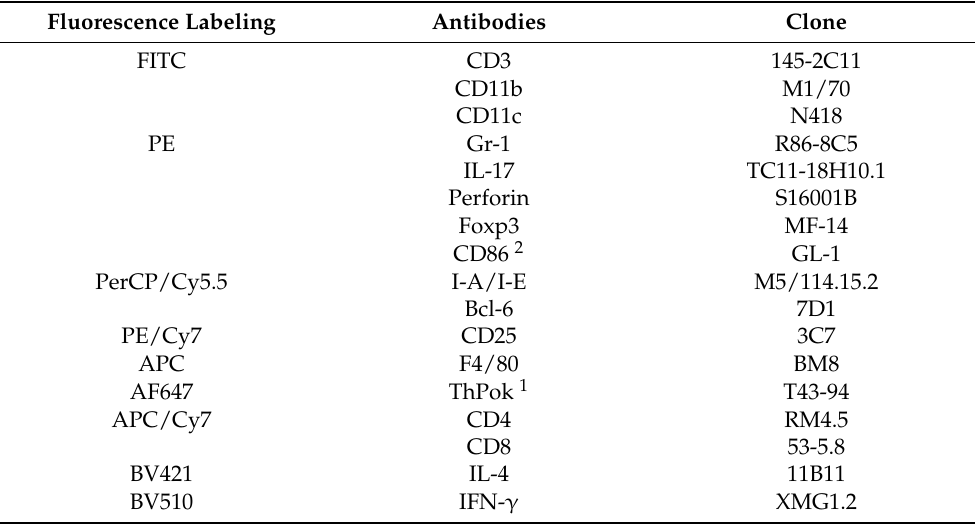
Table 1. Antibodies used in the FACS